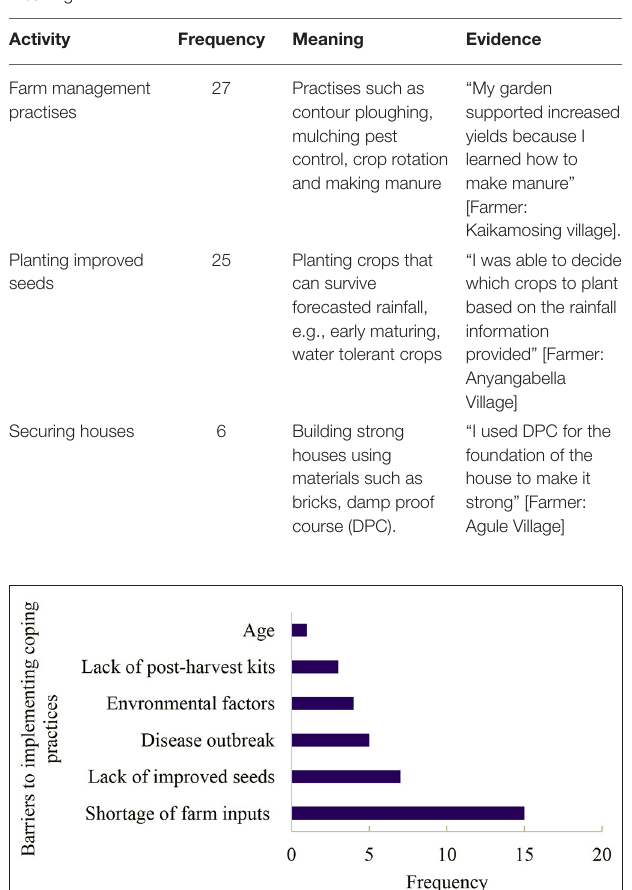
TABLE 5 | Common coping practises undertaken by the farmers and their meaning.